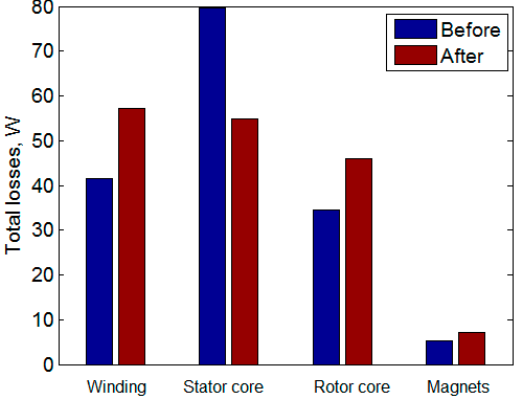
Figure 7. The losses in various parts in the FRMs at rated power.